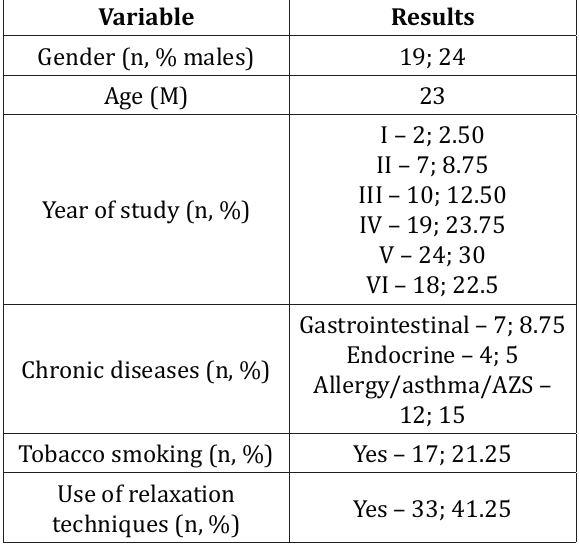
Table 1. Sociodemographic and clinical characteristic of examined